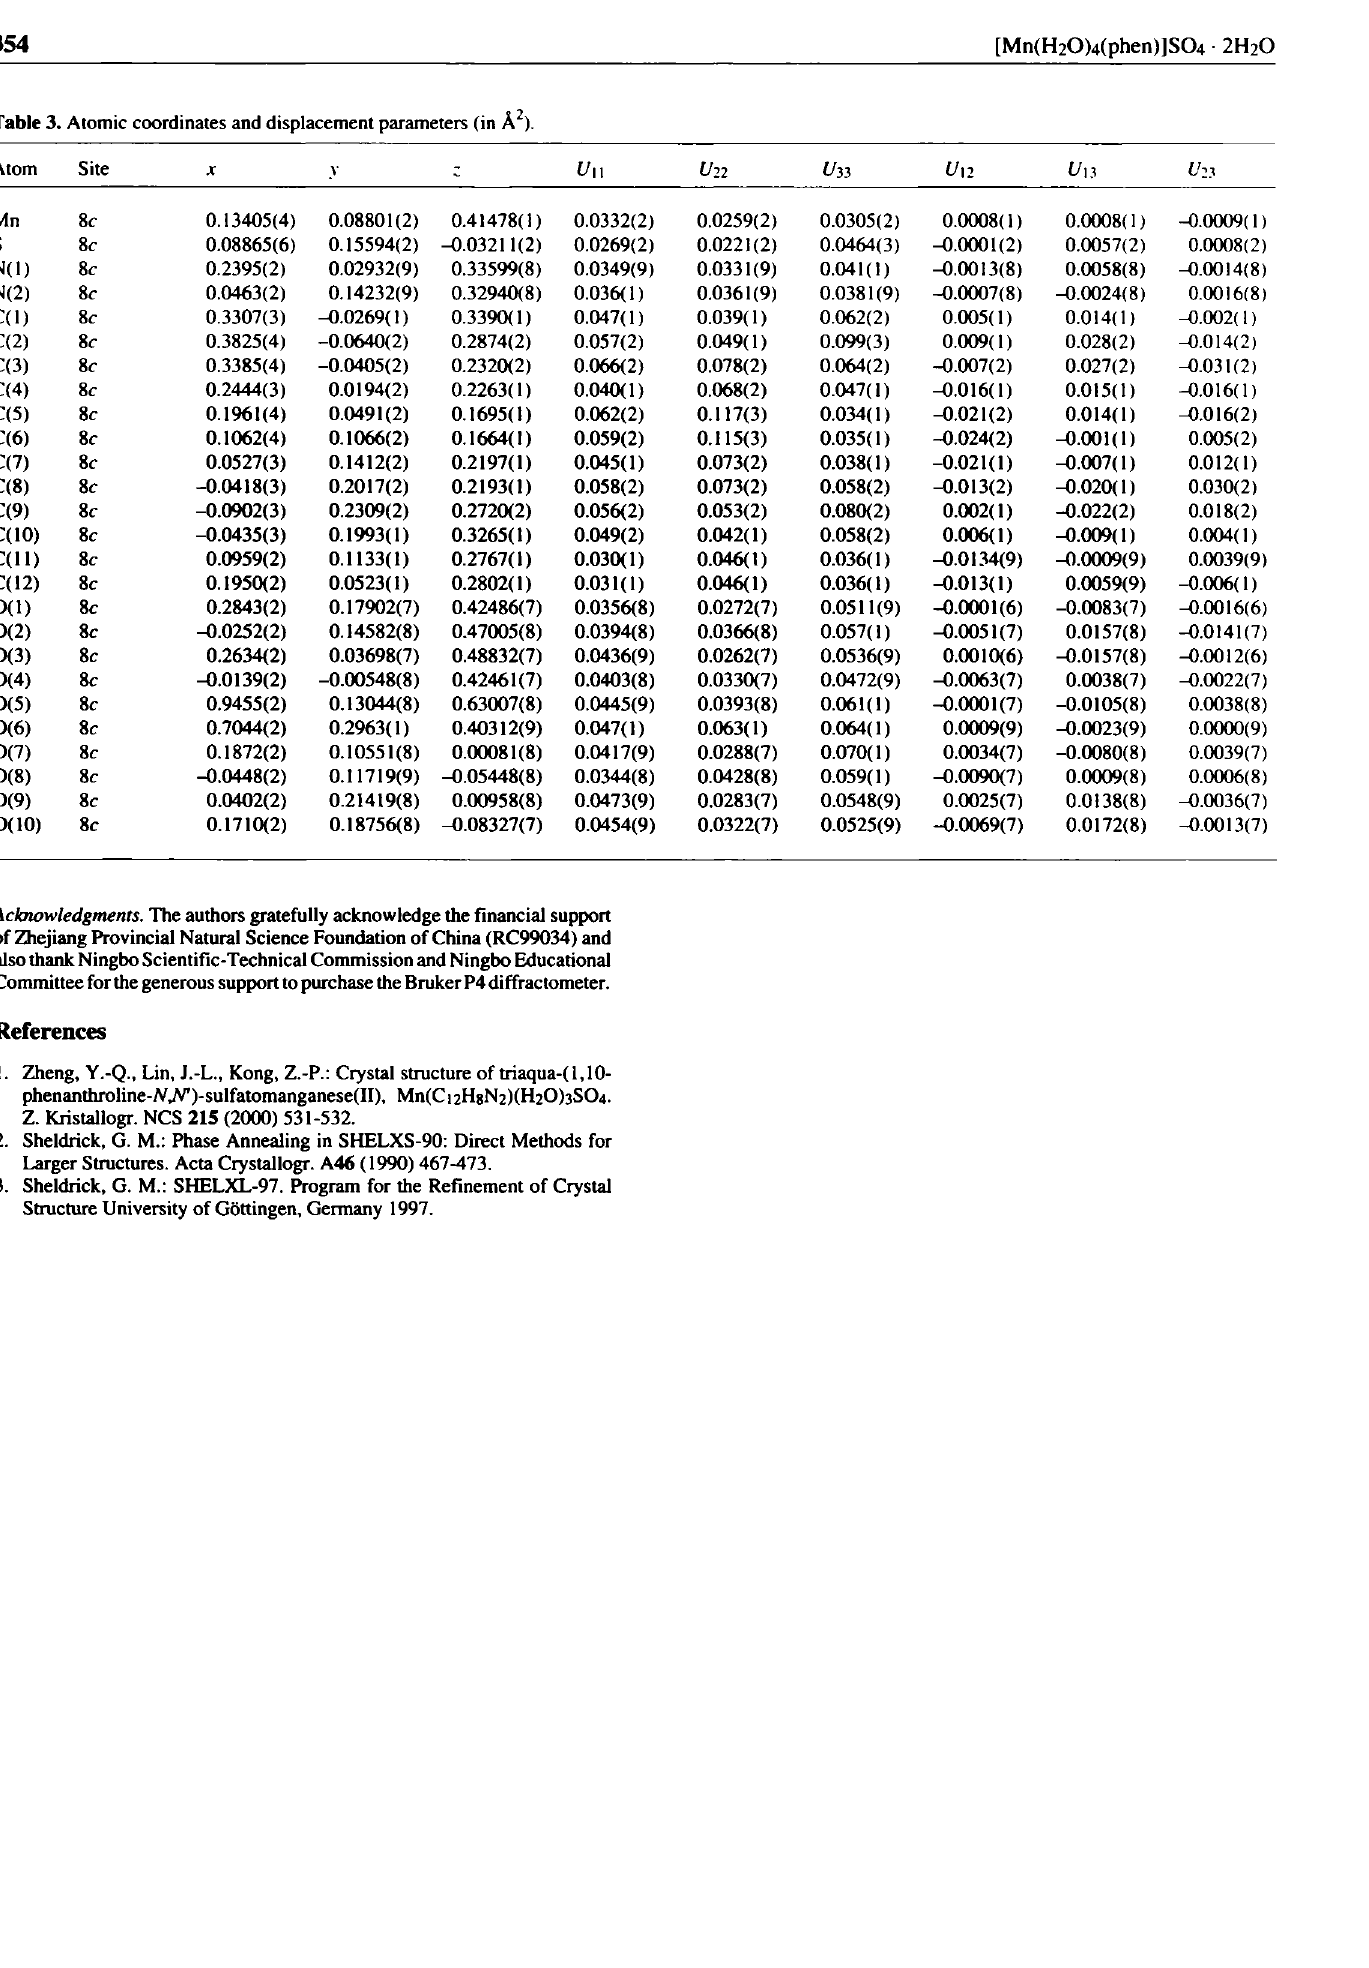
Table 3. Atomic coordinates and displacement parameters (in Ä 2